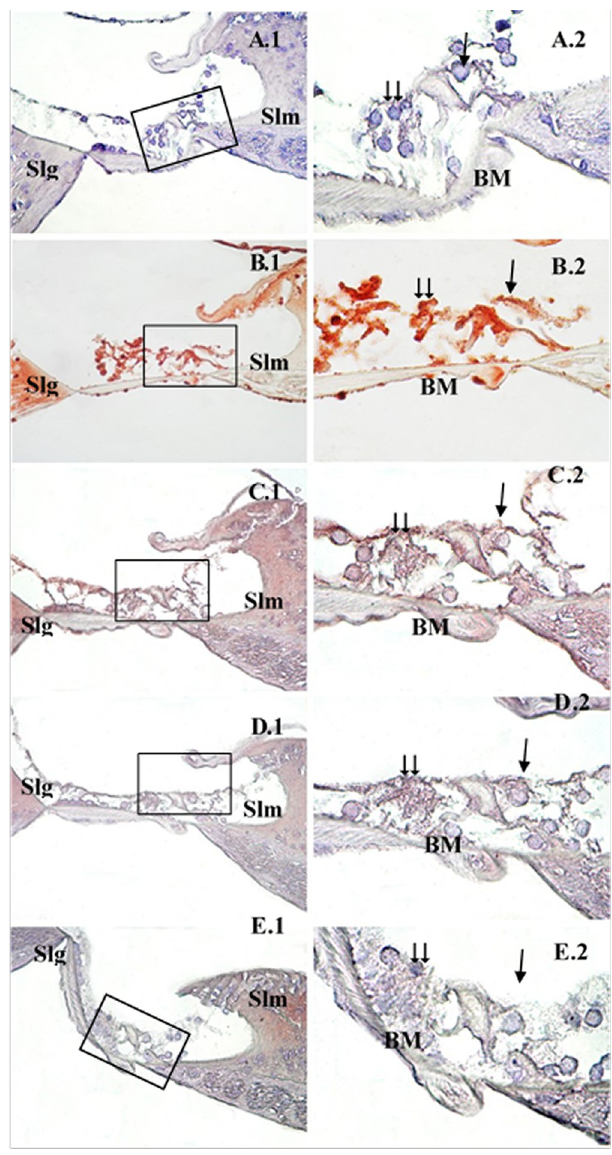
Fig 2. Caspase-8 immunohistochemistry staining in the cochlear Corti organ of the rat groups. ! : İ nner hair cells, ⇉ : Outer hair cells, Slm: Spiral limbus, Slg: Spiral ligament, BM: Basilar membrane, Control (A), DM (B), DM+PTS10 (C), DM+PTS20 (D), DM+PTS40 (E). Corti organ X40 (1), Corti organ X100 (2). Methyl-green ground